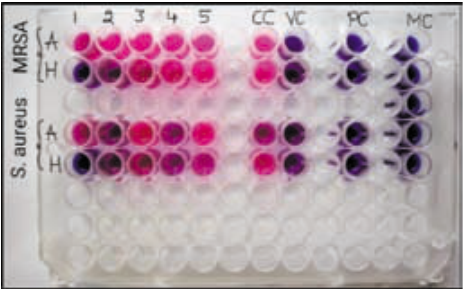
Fig. 3. Minimum inhibitory concentration of andrographolide and hordenine estimated using modified resazurin microtiter plate assay: A- andrographolide, H- hordenine, from left to